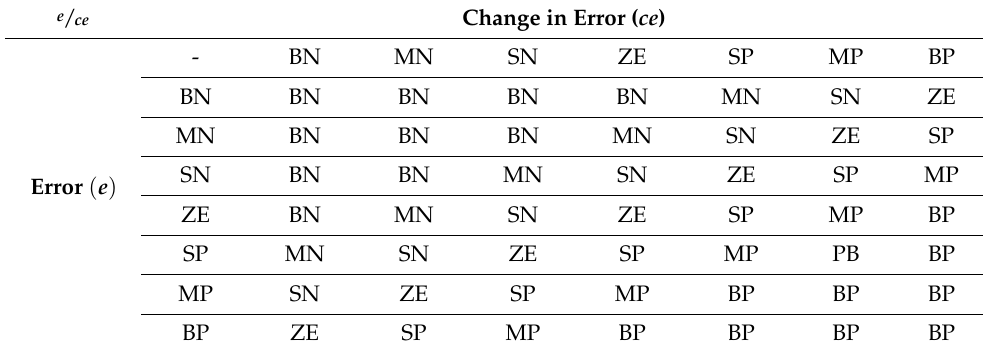
Table 2. Fuzzy rule base for the proposed system.